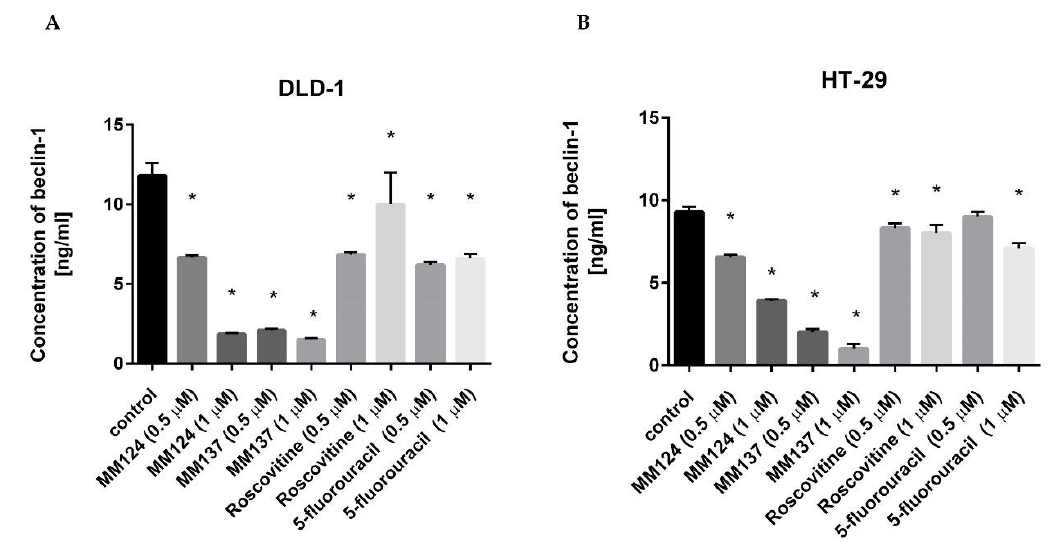
Figure 10. Concentration of beclin-1 in DLD-1 ( A ) and HT-29 ( B ) human colorectal cancer cells after 24 h incubation with novel 7-methyl-5-phenyl-pyrazolo[4,3- e ]tetrazolo[4,5- b ][1,2,4]triazine sulfonamide derivatives (MM124, MM137), 5-fluorouracil, and roscovitine. Data is presented as mean ± SD from three independent experiments done in duplicate. * p < 0.05 vs. control group.